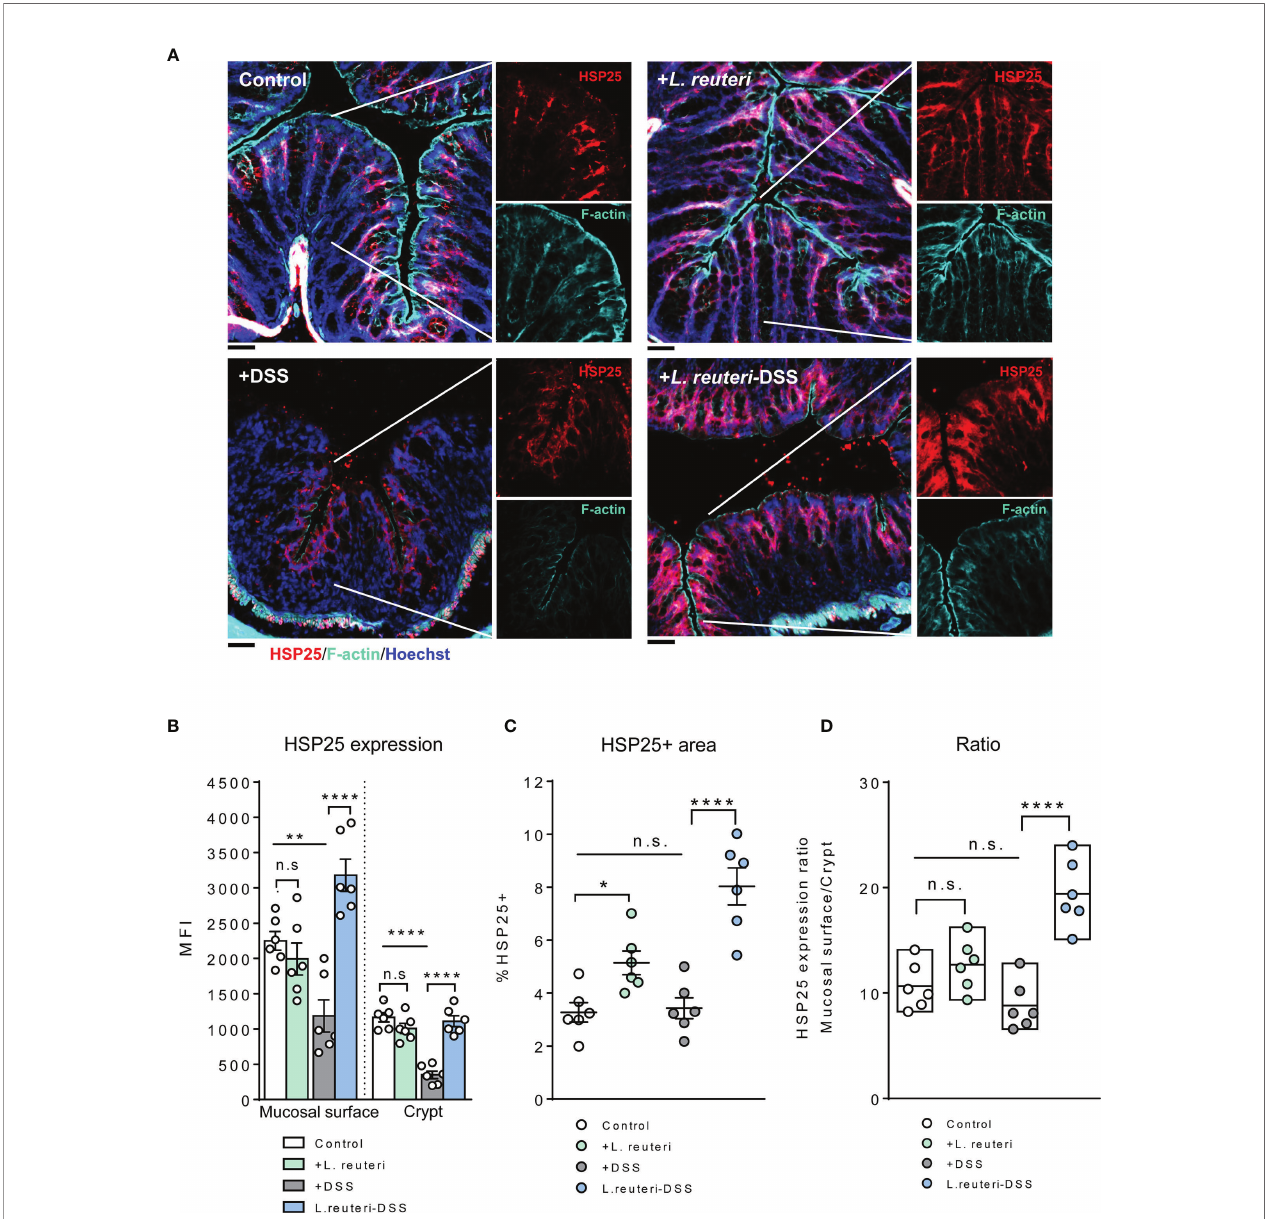
FIGURE 6 | Alterations of HSP25 expression in the colon in response to L. reuteri during DSS-induced colitis in young mice. (A) Representative images of colonic tissue sections stained with anti-HSP25 (red) and phalloidin (cyan). Sections were counterstained with Hoechst (blue). Scale bar = 50 m m. (B – D) Analysis and quanti fi cation of HSP25 expression, n = 6 mice per group (duplicate slides per mouse). Data are presented as mean ± SEM. * p < 0.05, ** p < 0.01, **** p < 0.0001 using ANOVA with Tukey ’ s post-hoc test. DSS, dextran sulfate sodium. ns, non signi fi